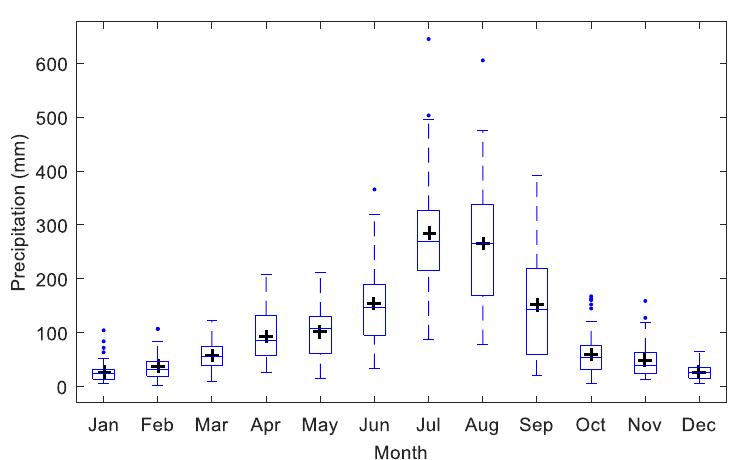
Figure 4. Boxplots of monthly precipitation data totals from 1973 to 2021 in South Korea. The upper and lower boundaries of each box indicate the upper and lower quartiles of the distribution; the median values are shown by the cross and line within the box, and the extreme upper data values are shown by dots above and below the box.